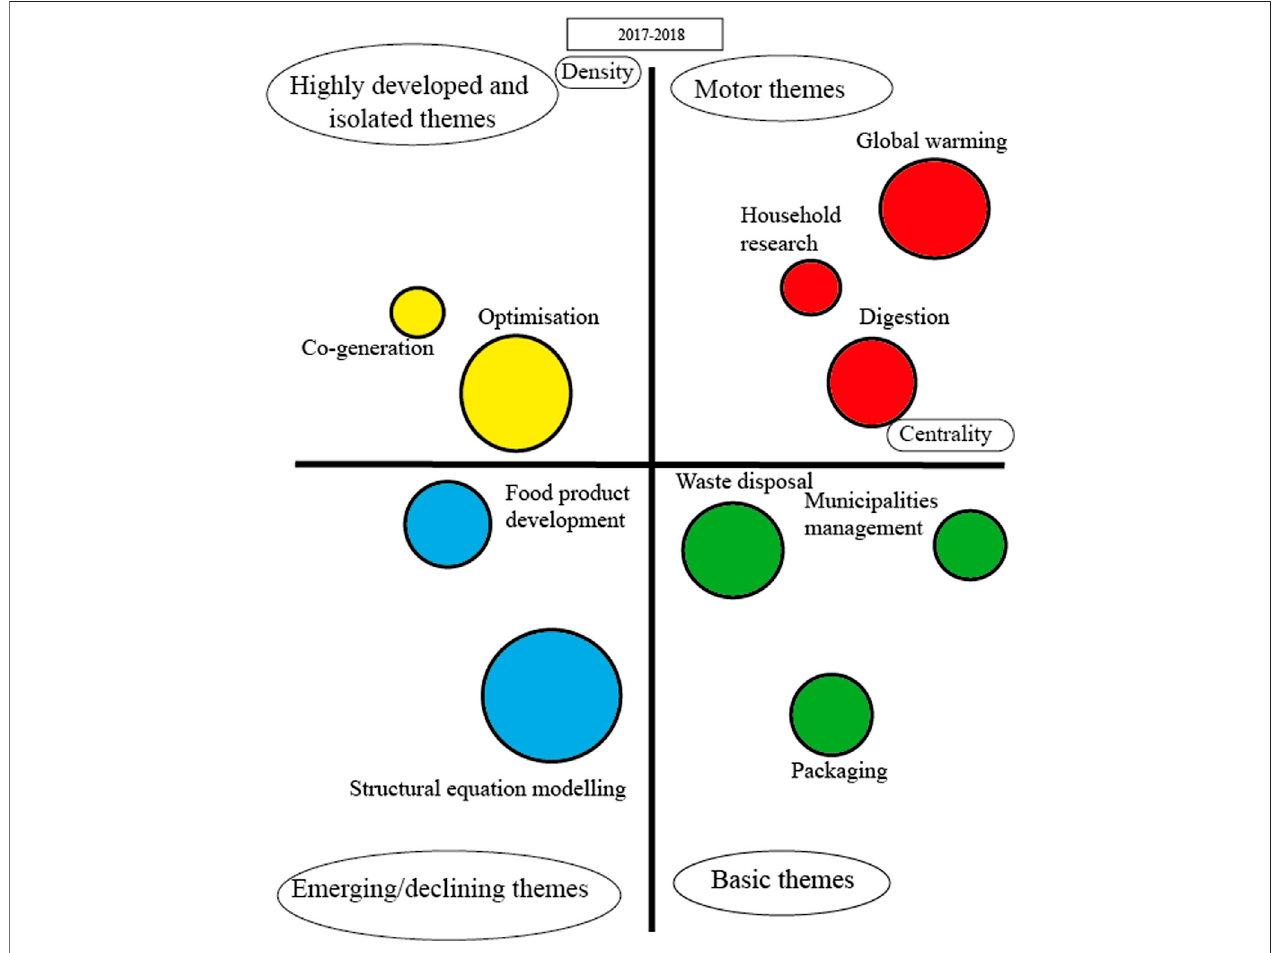
FIGURE 7 | Relative position of different themes relating to the household food waste problem between 2017 and 2018.